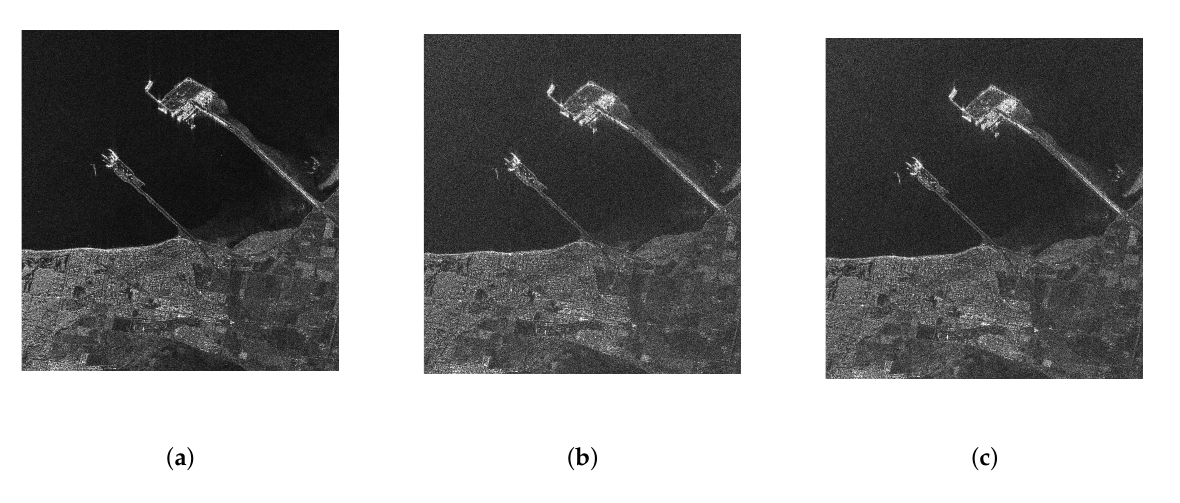
Figure 13. Imaging results of different quantization schemes. ( a ) High precision. ( b ) One-bit quantization. ( c ) Proposed two-bit quantization.